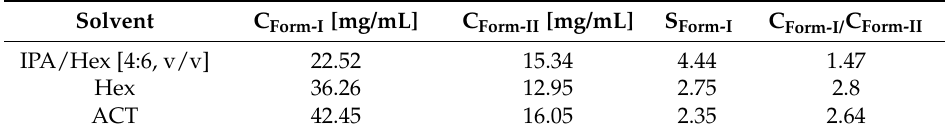
Table 2. Solubility of Form-I (C Form-I ) and Form-II (C Form-II ), the Supersaturation Level of Form-I (S Form-I ), and the Ratio of Solubility of Form-I/Form-II (C Form-I/ C Form-II ) in the Mixture of Solvent (ethanol)/Anti-solvent (5:5, v/v) at 35 ◦ C. The Initial Concentration of CLP in Ethanol was 100 mg/mL. Solvent C Form-I [mg/mL]